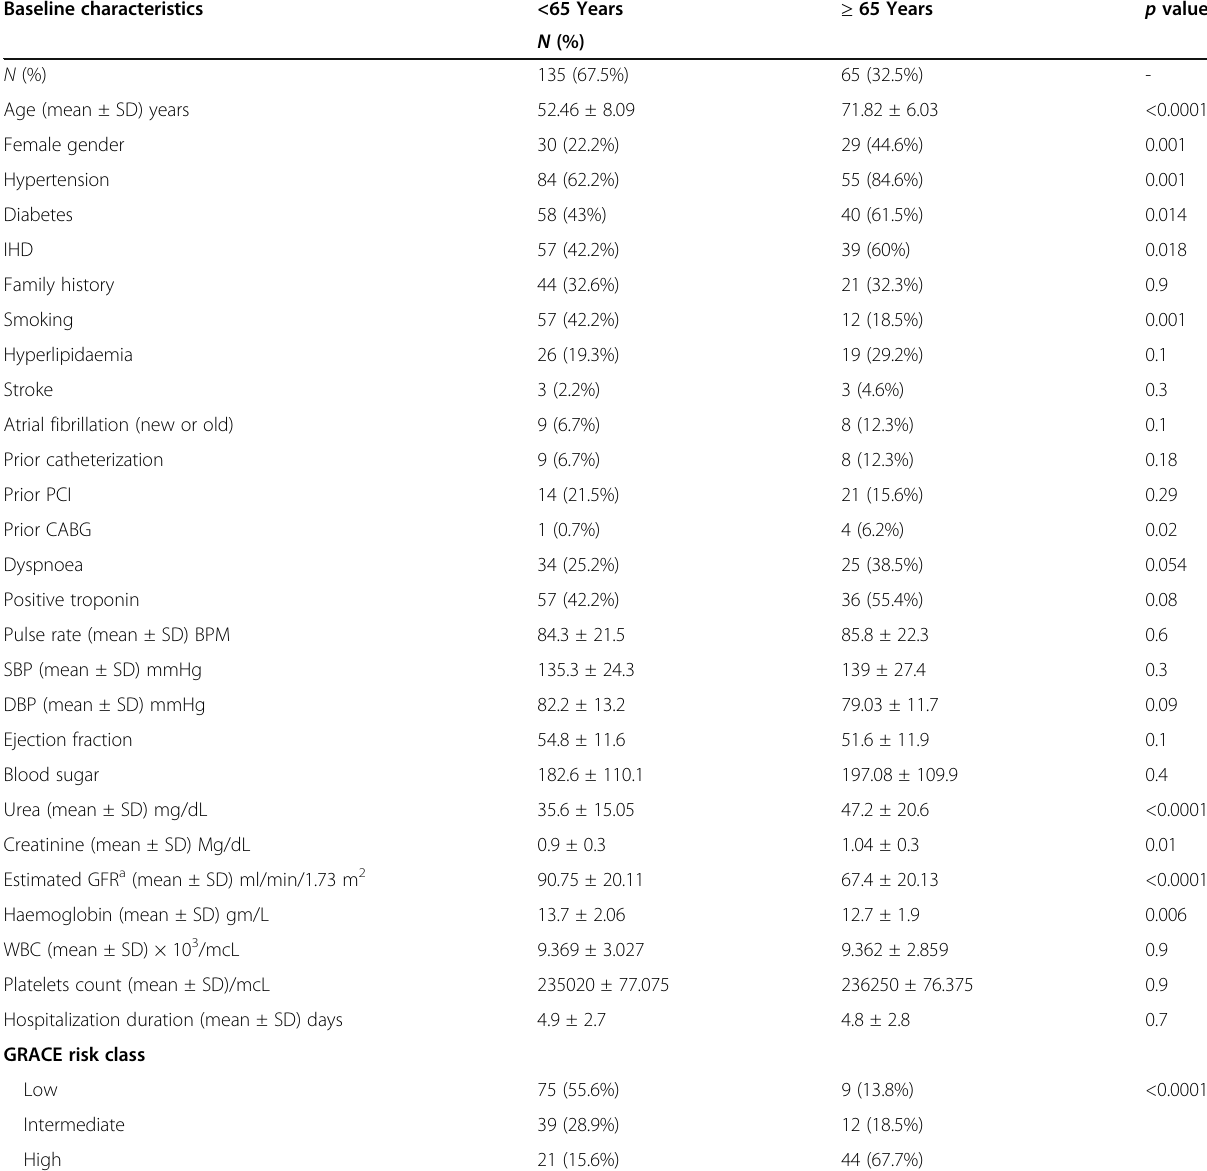
Table 1 Baseline characteristics in patients with NSTE-ACS according to age category Baseline